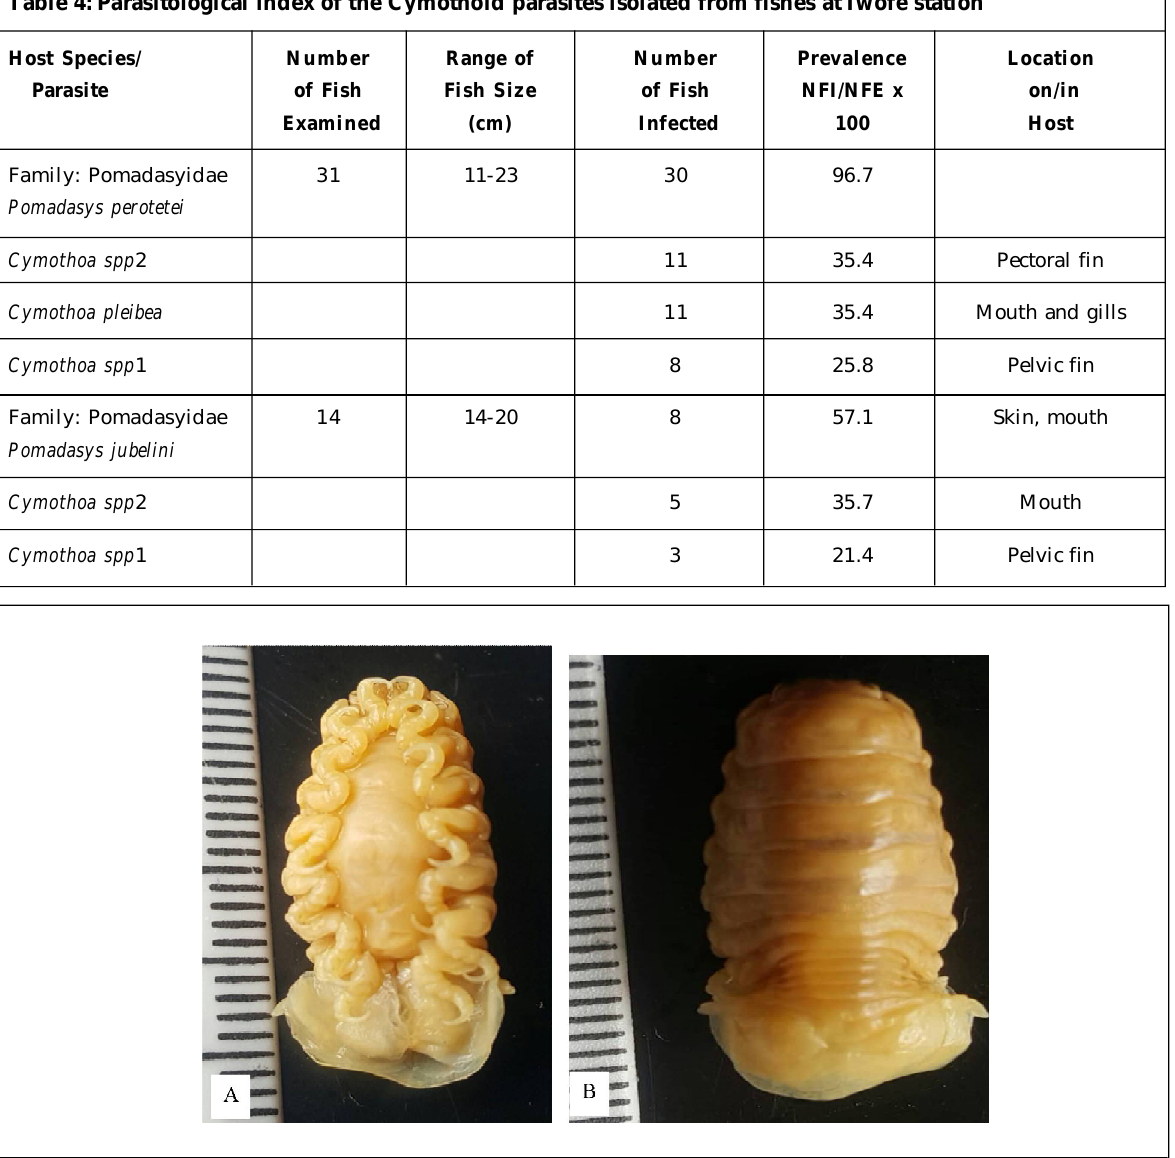
Table 4: Parasitological index of the Cymothoid parasites isolated from fishes at Iwofe station Host Species/ Number Range of Number Prevalence Location Parasite of Fish Fish Size of Fish NFI/NFE x on/in Examined (cm) Infected 100